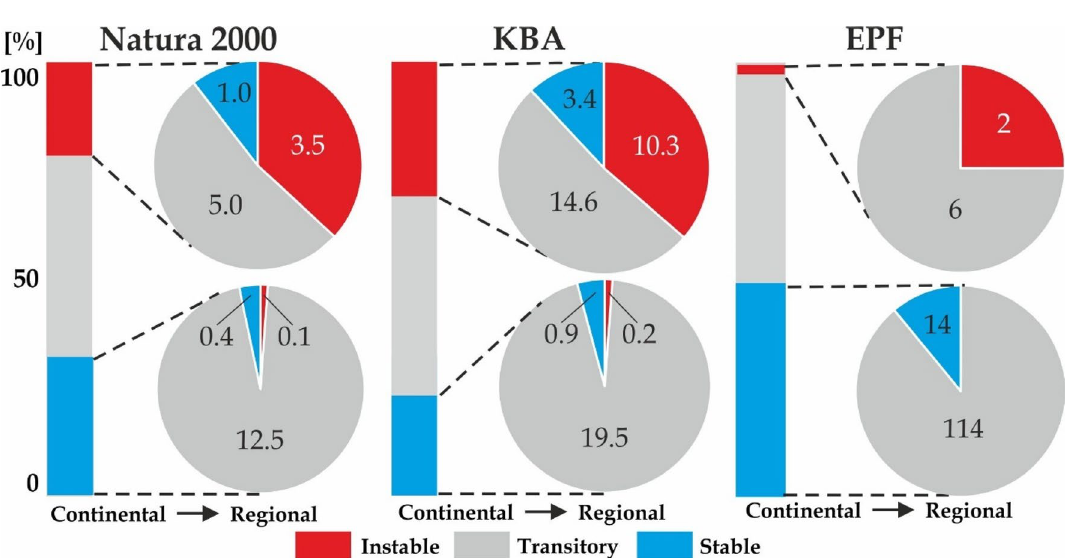
Figure 5. The proportion of Natura 2000, Key Biodiversity Areas, and European primary forests present in areas identified as zones of low and high climatic stability, relative to background climate change. Modelling was carried out at a continental (bars) and regional (pie chats) scales. Values in pie charts indicate areas of Natura2000 and KBA sites (mil. of ha), or the number of EPF in each climate stability category. Climatic stability as predicted under RCP4.5 or RCP8.5 and persisting throughout 2041–2100. Graphs were created in R v. 4.0.4. 26 . The final layout was created in CorelDraw v. 20.1.0.707 (2018 Corel